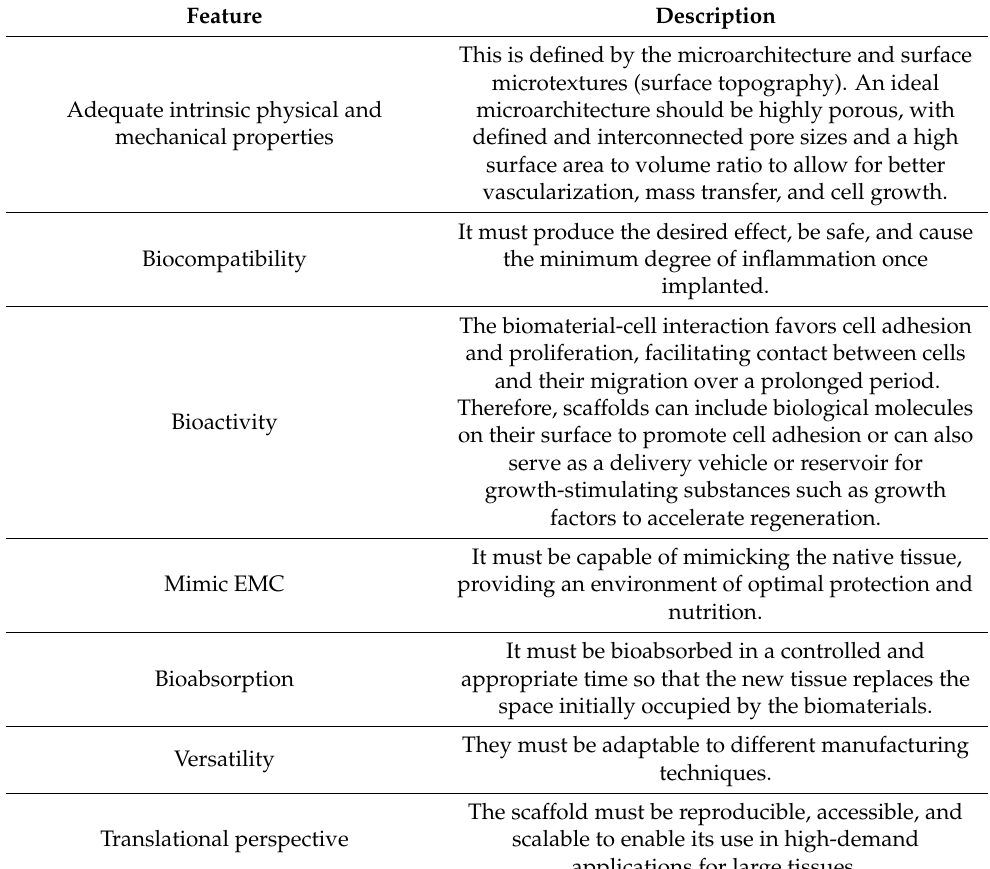
Table 1. Criteria for building an ideal